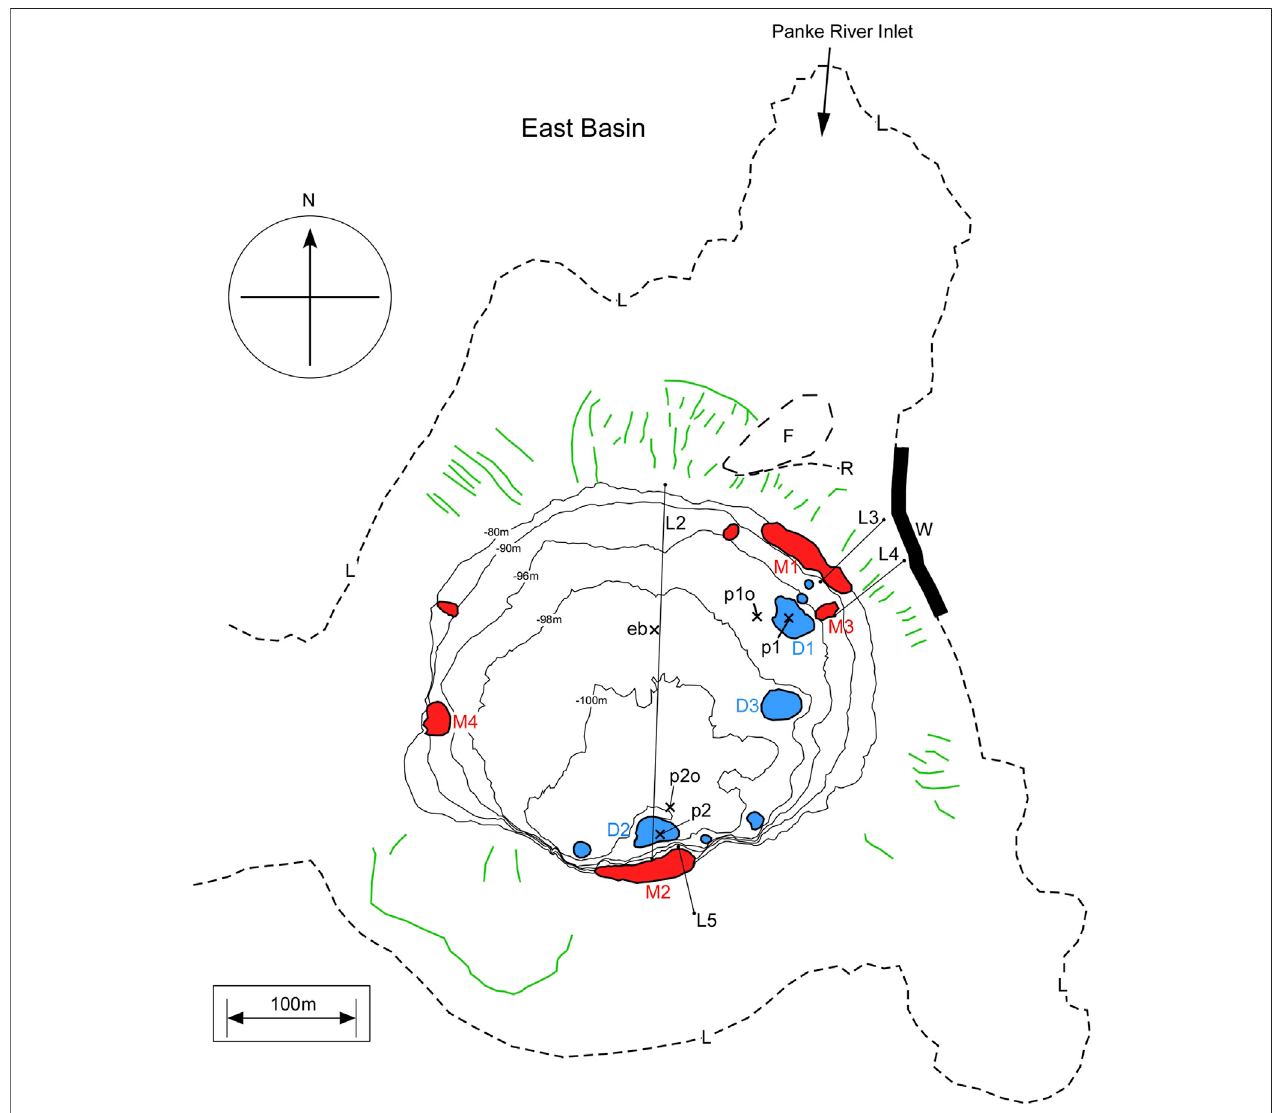
FIGURE 4 | Bathymetric features found in EB. The dashed line L indicates the outline of the lake water. The green curves indicate the grooves on the scarp of the basin. F is the region free of grooves. R is a small ridge on the scarp of the basin. W is the area affected by the wave generated by the 1984 limnic eruption (Sigurdsson et al., 1987). The red areas (i.e., M1, M2 M3, M4 and other small ones) indicate the mounds. The blue areas (i.e., D1, D2, D3 and other small ones) indicate the depressions.Pointsp1,p1o,p2,p2o,andebarethelocationsofCTDmeasurements.Theverticalcrosssectionsaredrawnin Figure3 alonglinesL2,L3,L4,and L5. The thin-solid curves are the depth